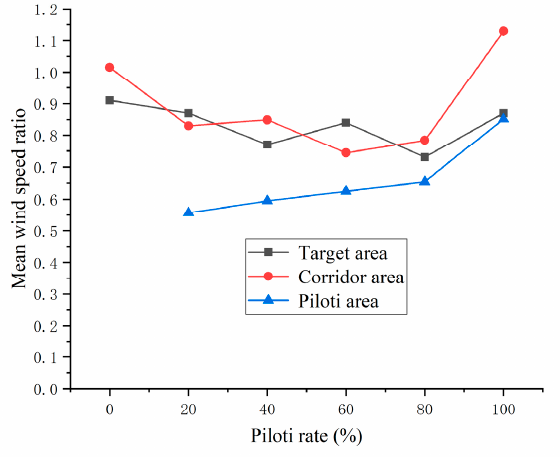
Figure 7. Variation of the mean wind speed ratio in the determinant model.